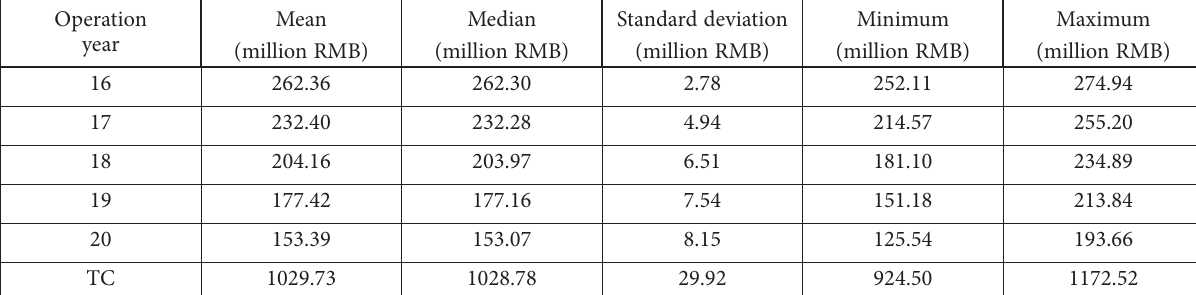
Table 5. Simulation outputs of annual discounted compensation and total